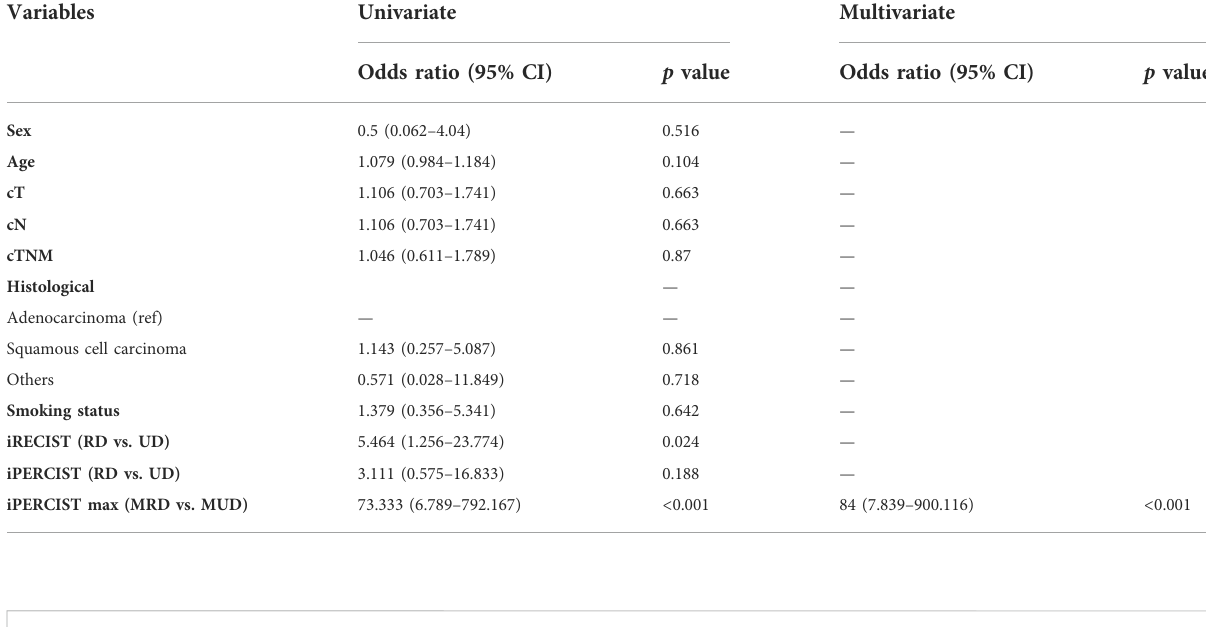
TABLE 2 Univariate and multivariate binary logistic regression analyses. RD: responsive disease; UD: unresponsive disease; MRD: metabolic responsivedisease;MUD:metabolicunresponsivedisease;cT:clinicalTstage;cN:clinicalNstage;cTNM:clinicalTumor-nodal-metastasisstage. Variables